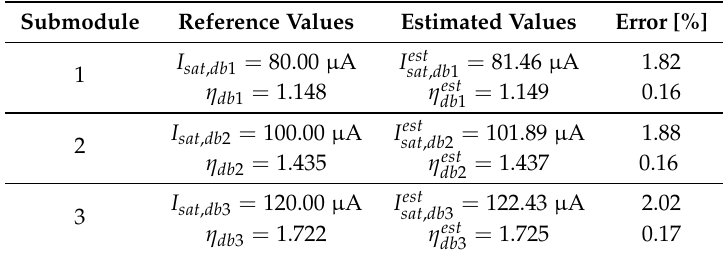
Table 4. Relative errors for the estimated parameters under simulation scenario